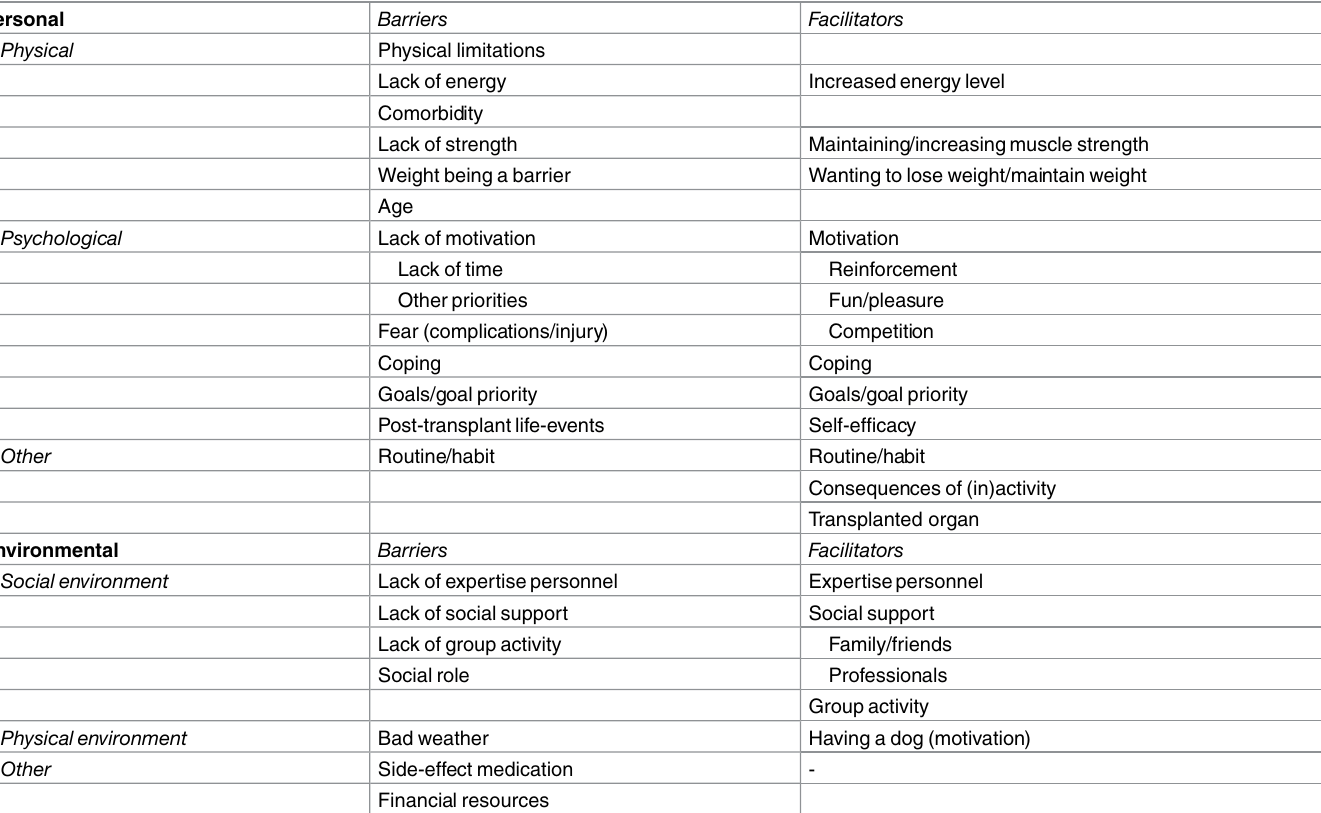
Table 3. Overviewof personaland environmentalbarriers and facilitators to physicalactivityin recipientsof solidorgan